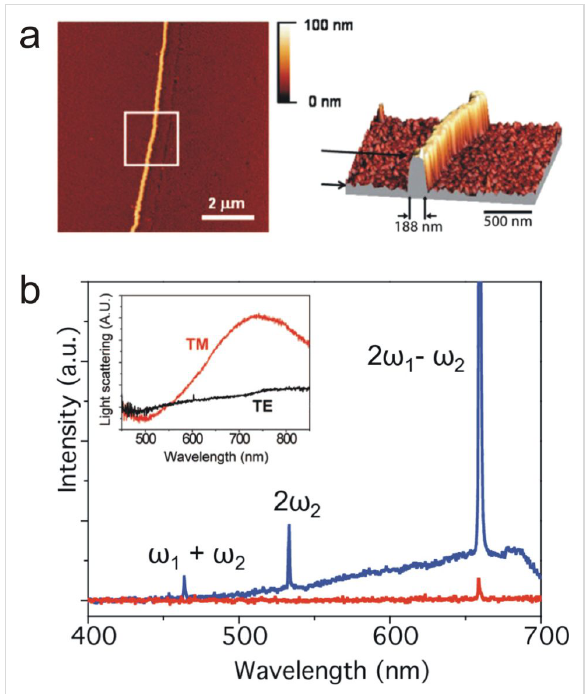
Figure 5: (a) AFM image of a single rectangular gold nanowire with an aspect ratio of ca. 7. (b) CARS, SFG and SHG emission from the rectangular gold nanowire. The red and blue curves correspond to a light polarization parallel and normal to the wire, respectively. The inset shows the white light scattering spectra of the wire with TM and TE polarized light. Figures adapted with permission from [32], Copyright 2010 Optical Society of America, and from [59], Copyright 2008 Amer- ican Chemical